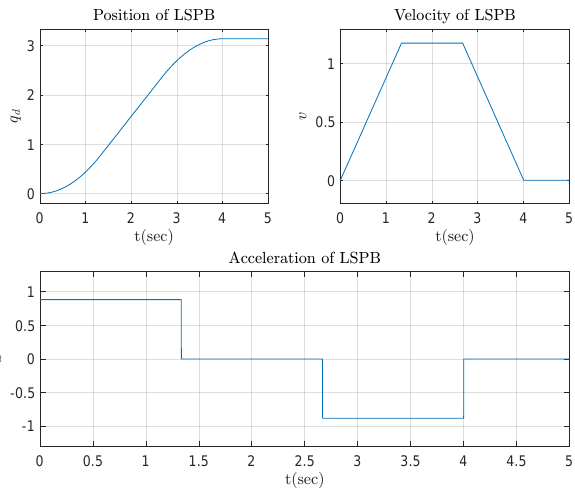
Figure 2. LSPB trajectory.